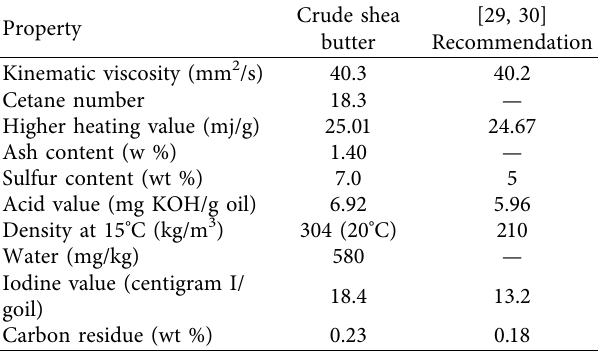
Table 1: Comparison of crude shea butter oil properties to liter- ature standards.